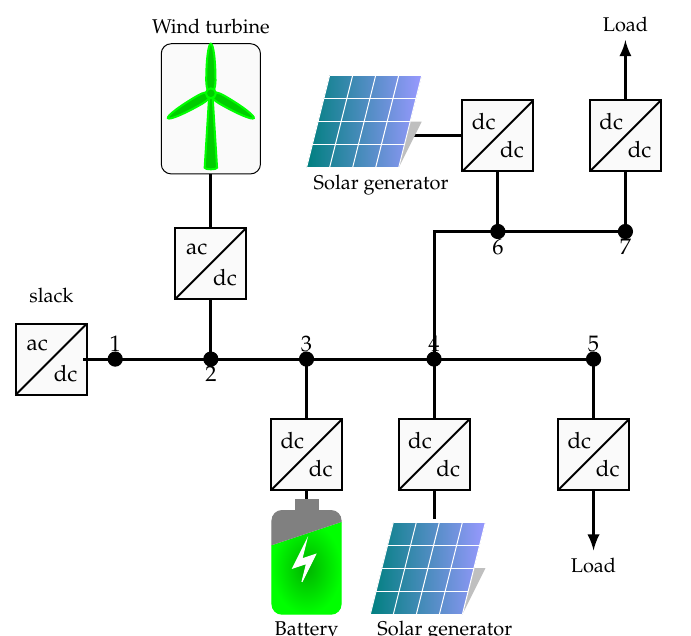
Figure 1. Some classical converters employed to interface distributed energy resources and loads in DC